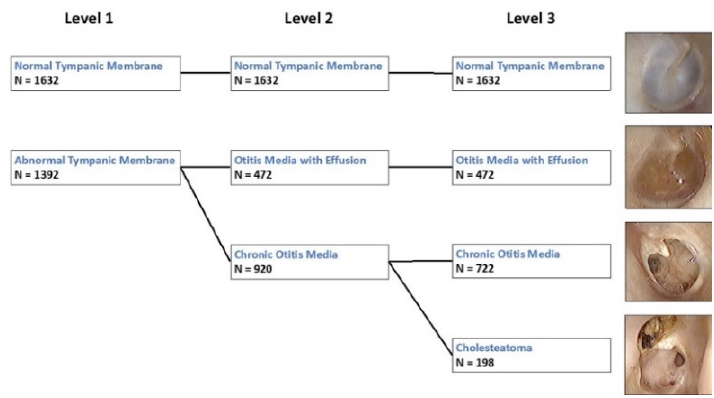
Figure 1. Classification of tympanic membrane abnormalities.